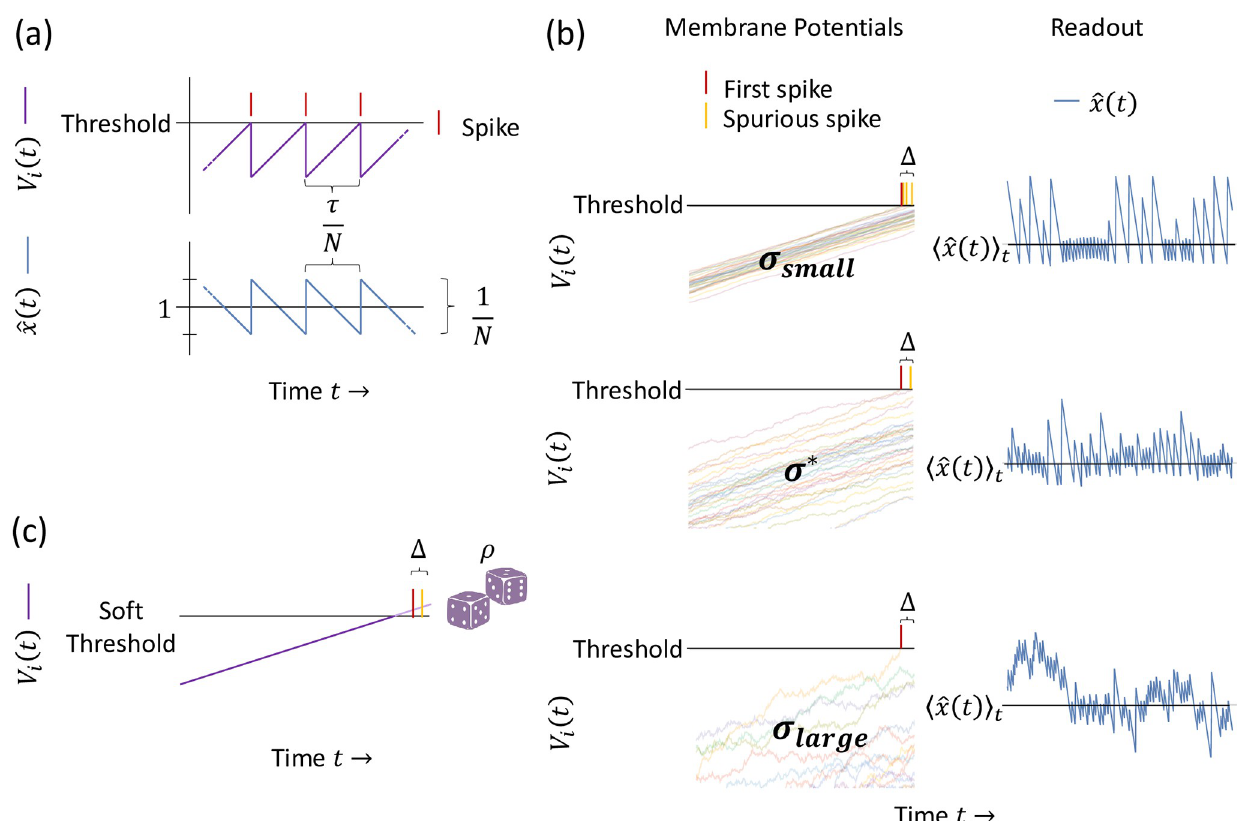
Fig 1. Tight-balance spiking network dynamics and readout. (a) Nominal dynamics. When there are no spike propagation delays and zero noise, the membrane potentials (purple) follow the same trajectory in time. When the population reaches threshold, one neuron’s spike (red) instantaneously inhibits all the neurons, preventing further spikes. This produces perfectly regular spikes, like clockwork with an approximate period of t to the readout, creating a tight, zig-zag approximation ^ x ð t Þ (blue) for the encoded signal, x ( t ) = 1 in this case. (b) The effect of delays and noise. When delays are present and noise is added to the membrane potentials (left, multicolor), two effects appear that decrease the fidelity of the readout ^ x ð t Þ (right, blue): variation in spike-timing and synchronous spurious spikes. The noise on the membrane potentials ( σ ) creates variations in the time it takes membrane potentials to reach threshold—a deviation from the perfectly regular spikes in (a). And after the first neuron in the population crosses threshold and spikes (red), there is a delay Δ until the other neurons receive inhibition, and thus some extra neurons may spike—spurious synchronous spikes (yellow). Given a fixed delay, too little noise σ small does not spread the membrane potentials enough to prevent a large number of spurious spikes, and too much noise σ destroys the fidelity of the code altogether. An optimal noise level exists, σ � . (c) Soft-threshold model. In the soft-threshold model, neurons large spike probabilistically once their membrane potentials surpass threshold, with a spiking probability rate ρ . As ρ is varied (not illustrated), one finds a relationship analogous to the noise level trade-off for the LIF model shown in (b): too small ρ creates large variations in spike times, and too large ρ creates many spurious spikes during the delay. Thus, an optimal ρ � exists.